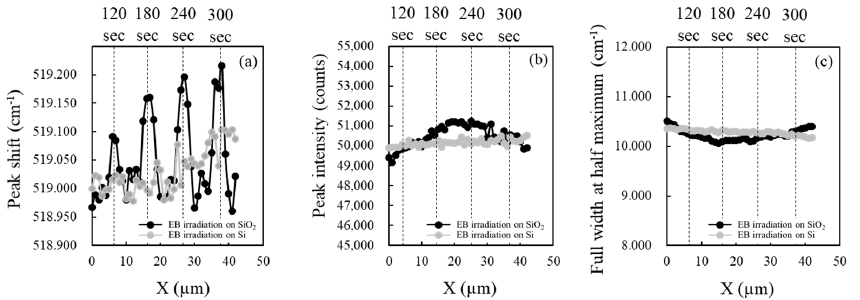
Figure 7. The influence of EB irradiation on the SiO 2 and Si surface observed with Raman spectroscopy; ( a ) peak shift, ( b ) peak intensity, and ( c ) FWHM.